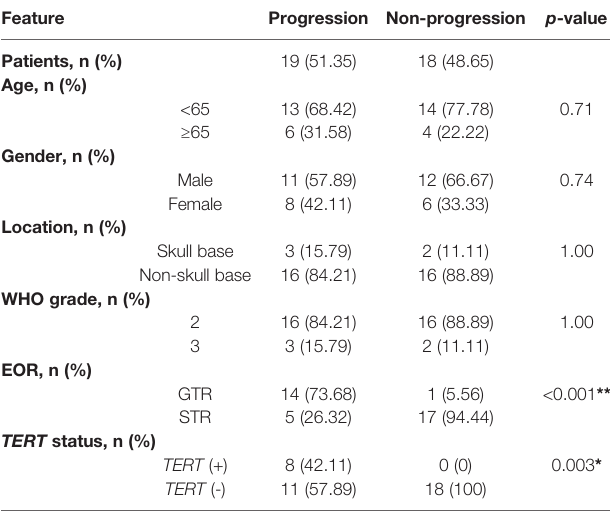
TABLE 1 | Analysis of progression factors in de novo HGM patients after RT. Feature Progression Non-progression p -value Patients, n (%)